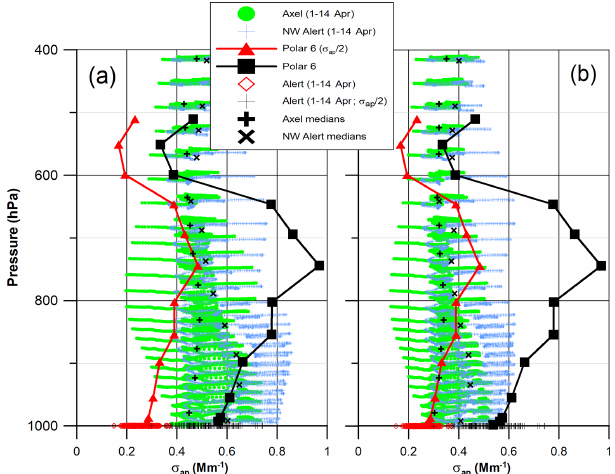
Figure 11. Vertical profile plots of σ ap with atmospheric pres- sure showing median values based on Polar 6 observations (black points). Red points represent the Polar 6 σ ap / 2. Data from the Alert observatory for 1–14 April are shown for σ ap (black squares) and σ ap / 2 (red squares). The model results are for 1–14 April, with the green dots representing the Axel grid and blue crosses representing the NW Alert grid. (a) Model results for the Allcore assumption and (b) model results for the Rshell